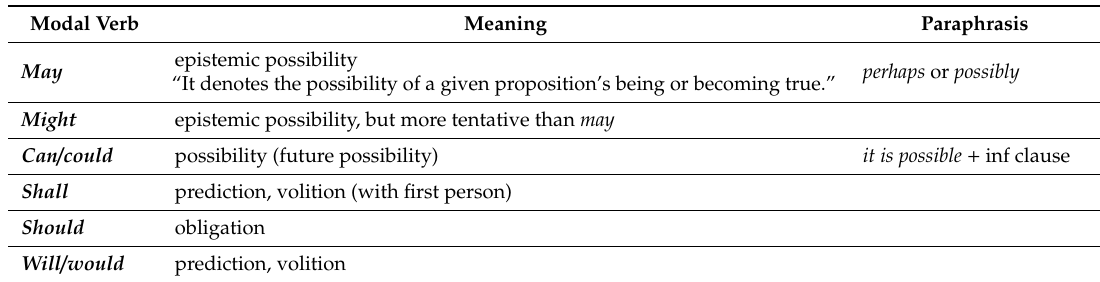
Table 1. Meaning of modal verbs (according to Quirk 1985).